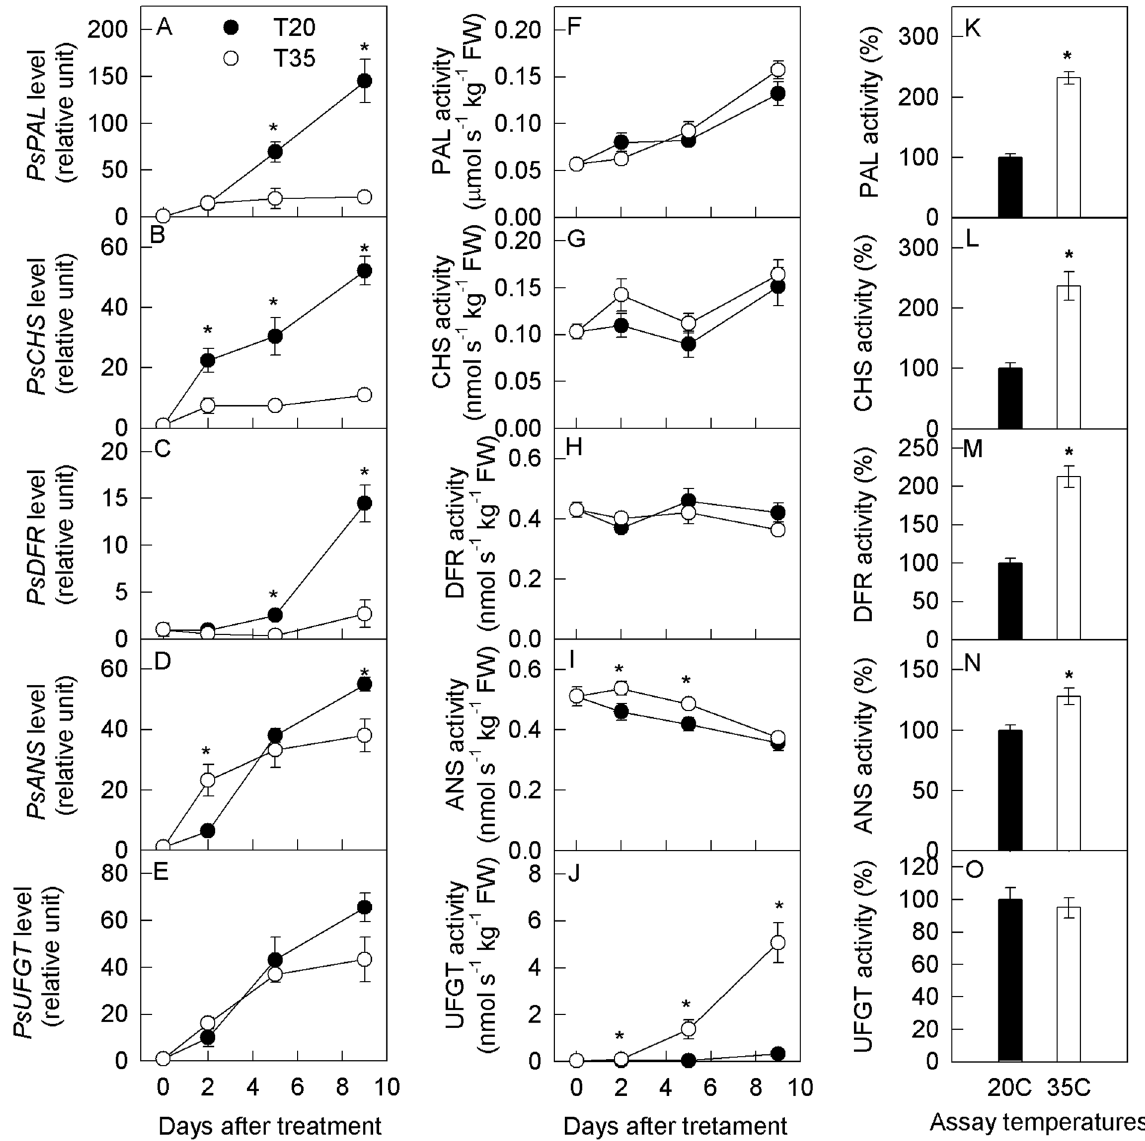
Figure 2. Transcription levels of key genes and the activities of correspondingly encoding enzymes involved in anthocyanin synthesis in the peel of plum fruits treated at 20 °C and 35 °C for different time in the dark. Panel A–E, mRNA level; Panel F–J, enzyme activity assayed at 20 °C; Panel K–O, enzyme activity in 35 °C treated fruit for 9 days assayed at 20 °C and 35 °C. Each data point represents mean ± SE (n = 5). The asterisk indicates a significant difference between two temperature treatments at P < 0.05, t -test. PAL, phenylalanine ammonia- lyase; CHS, chalcone synthase; DFR, dihydroflavonol reductase; ANS, anthocyanidin synthase; UFGT, UDP glucose:flavonoid 3-O-glucosyltransferase. The same as